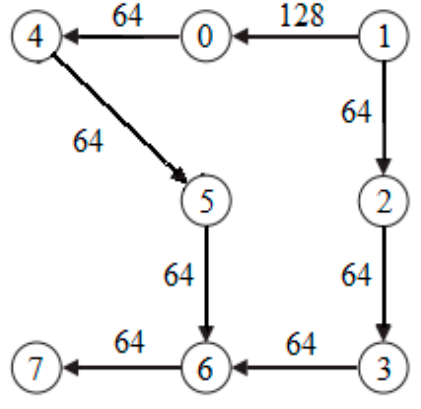
Figure 4. Simple task graph PIP.